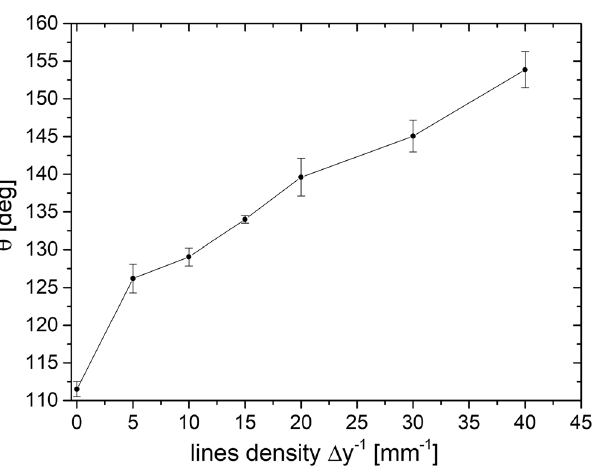
Figure 3. Change in the static water contact angle θ as a function of increasing line density ∆ y − 1 on a laser- textured AISI 316 L surface functionalized with 30-nm FAS-SiO 2